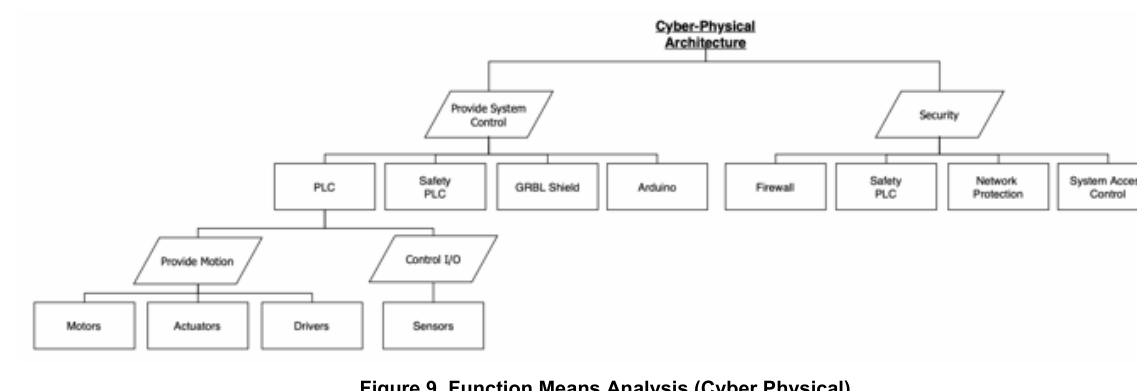
Figure 8. Quality Function Deployment (QFD)